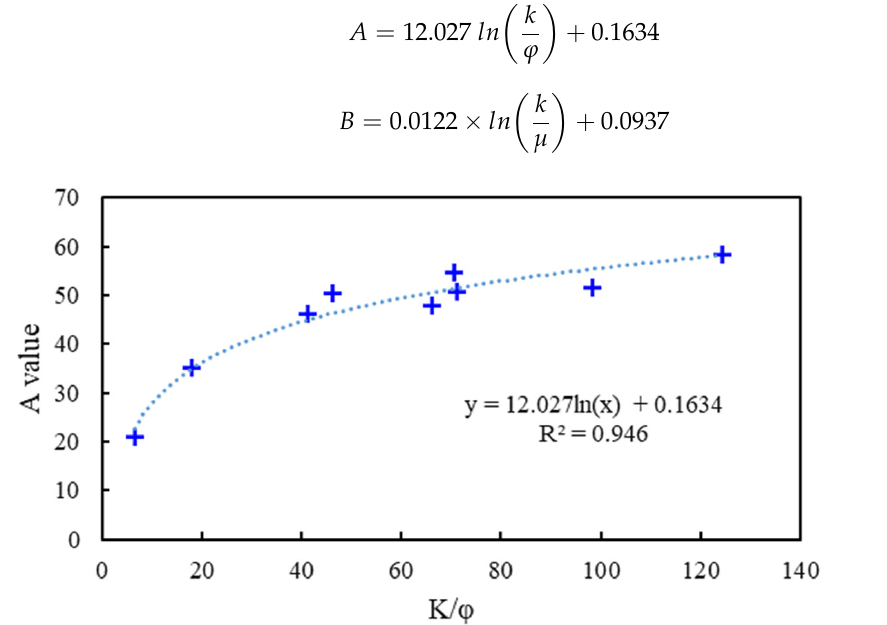
Figure 7. The relationship between the value of coefficient A and the ratio of k/φ.